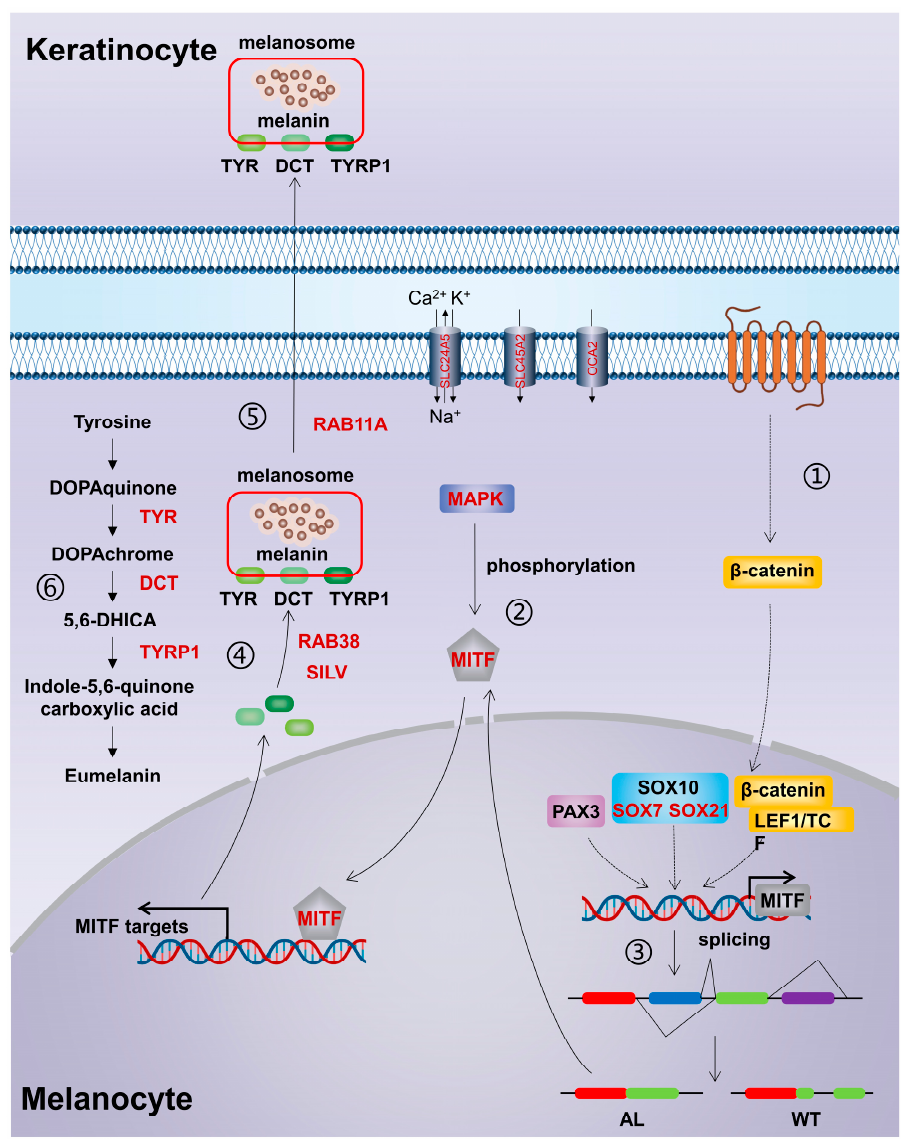
Figure 8. Diagram of putative gene pathways in the Andrias davidianus skin pigmentation process. ① Wnt signaling pathway; ② MAPK signaling pathway; ③ MITF splicing; ④ The formation and maturation process of melanosome; ⑤ Melanosome transportation; ⑥ The melanin biosynthesis pathway. The red marked genes represent DEGs in WT compared to AL Andrias davidianus . Dotted lines represent the events that are different or undefined in the pigmentation of Andrias davidianus compared with other vertebrates.